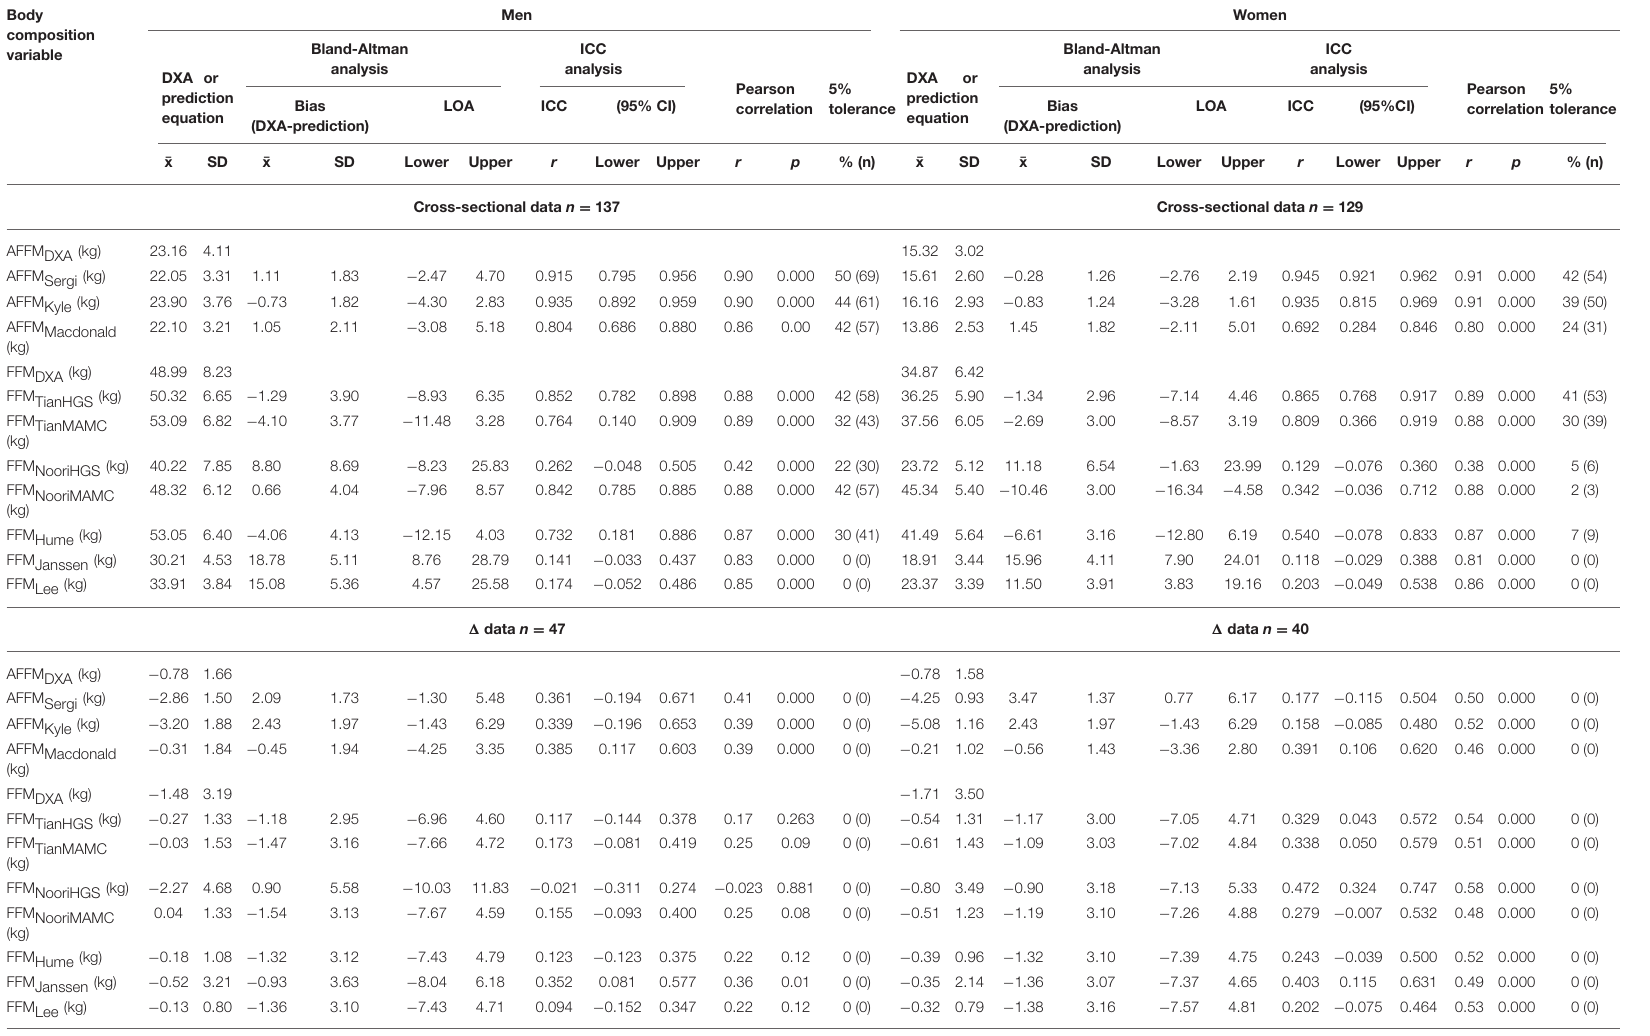
TABLE 3 | Agreement between DXA and prediction equations for AFFM and FFM in total sample stratified by sex. Body composition